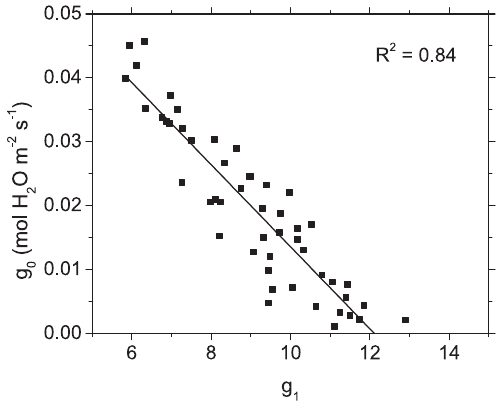
Figure 16. Relationship between g 0 and g 1 for the 50 simulations with the lowest root mean square error in latent heat flux. Data are from Fig. 15. Analysis of GPP errors shows a similar negative cor- relation (not